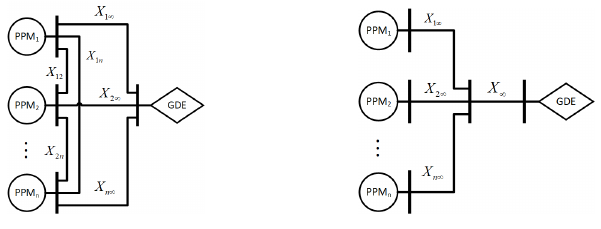
Figure 4. New control model for multiple